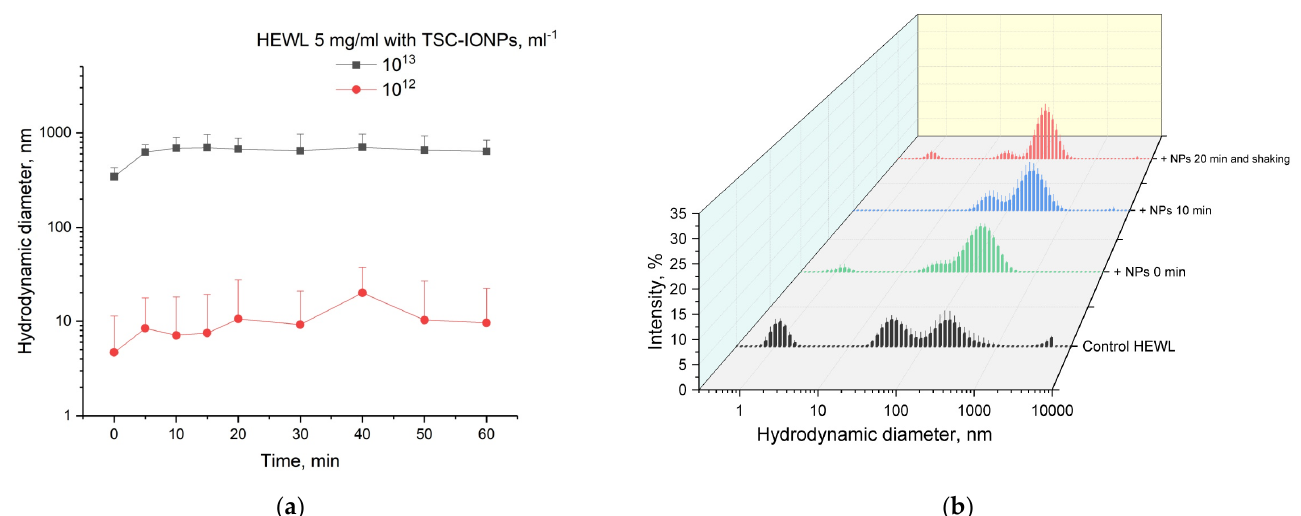
Figure 7. ( a ) Time dependence of the average size of hydrodynamic diameter of HEWL (5 mg/mL) for TSC-IONPs (10 12 and 10 13 mL − 1 ). Results are presented as mean and SD for three independent experiments. ( b ) DLS intensity data for solution HEWL (10 mg/mL) with TSC-IONPs (10 12 mL − 1 ): HEWL control, immediately after the addition of NPs, after 10 min, after 20 min; in addition, the sample was shaken for 10 s on a Biosan V1-plus vortex. Mean and SD were calculated from five measurements. Table 2. ζ -potential (mV), hydrodynamic diameters of the first peaks (MADLS data), and pH (electrode InLab Expert Pro-ISM measured in SevenExcellence pH/Cond meter S470) for HEWL and TSC-IONPs (10 13 NPs/mL) and the association. Results are presented as mean and SD for three independent experiments.